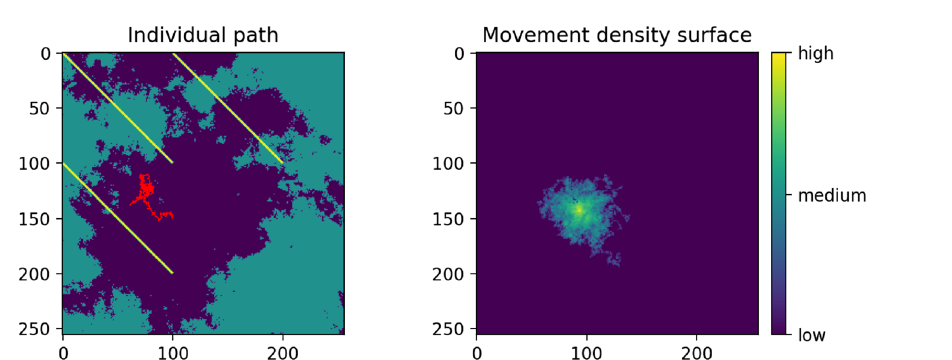
Figure 3. Schematic for configuring the Pathwalker movement model.